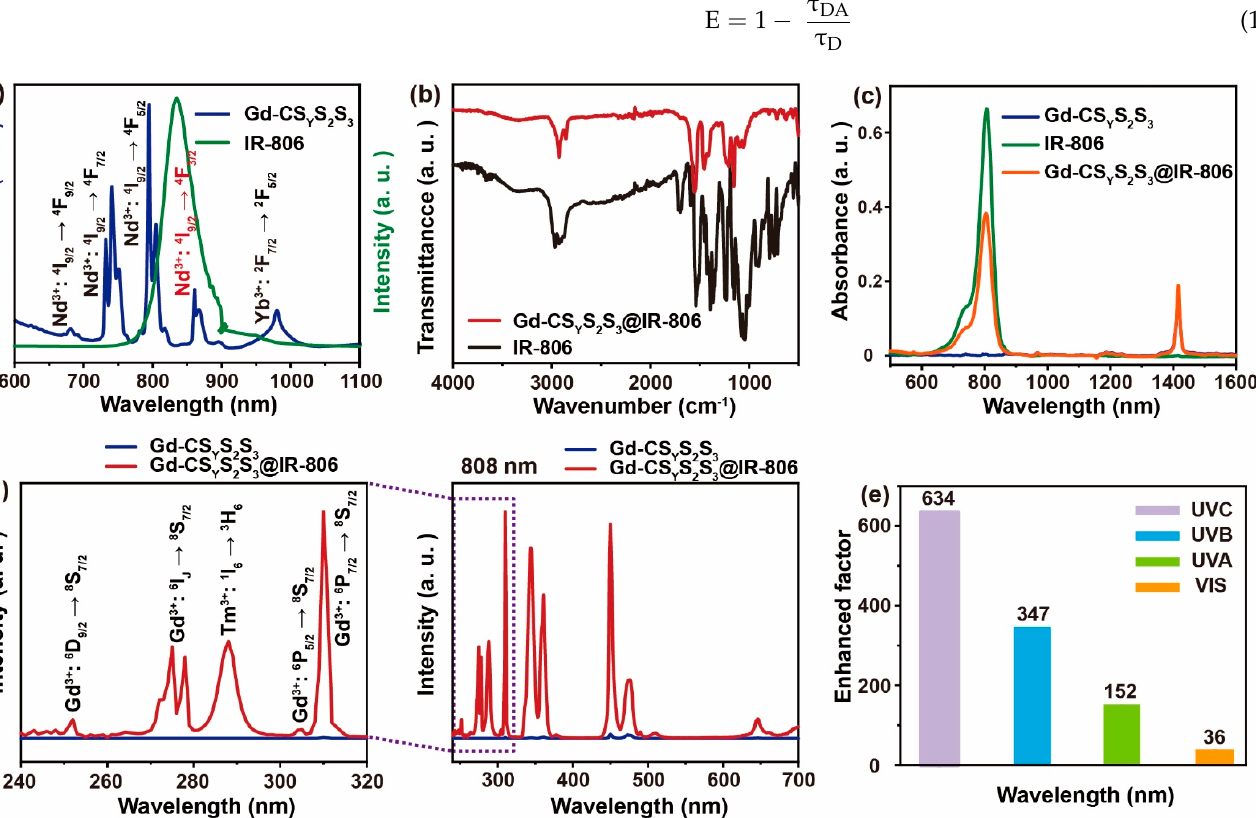
Figure 2. Preparation and characterization of Gd-CS Y S 2 S 3 @IR-806. ( a ) IR-806 emission spectrum and Gd-CS Y S 2 S 3 nanoparticles absorption spectrum. ( b ) FTIR of Gd-CS Y S 2 S 3 @IR-806 and IR-806. ( c ) The absorption spectra of Gd-CS Y S 2 S 3 , IR-806, and Gd-CS Y S 2 S 3 @IR-806. ( d ) Emission spectra of Gd-CS Y S 2 S 3 with and without IR-806 loading under 808 nm CW diode laser at a power density of 10 W/cm 2 . ( e ) The enhancement factors of upconversion emission were obtained by comparing the results for samples with and without IR-806 loading. The emission intensities were calculated by integrating the spectral intensities in the UVC (240–280 nm), UVB (280–320 nm), UVA (320–400 nm), and visible (400–650 nm) ranges.